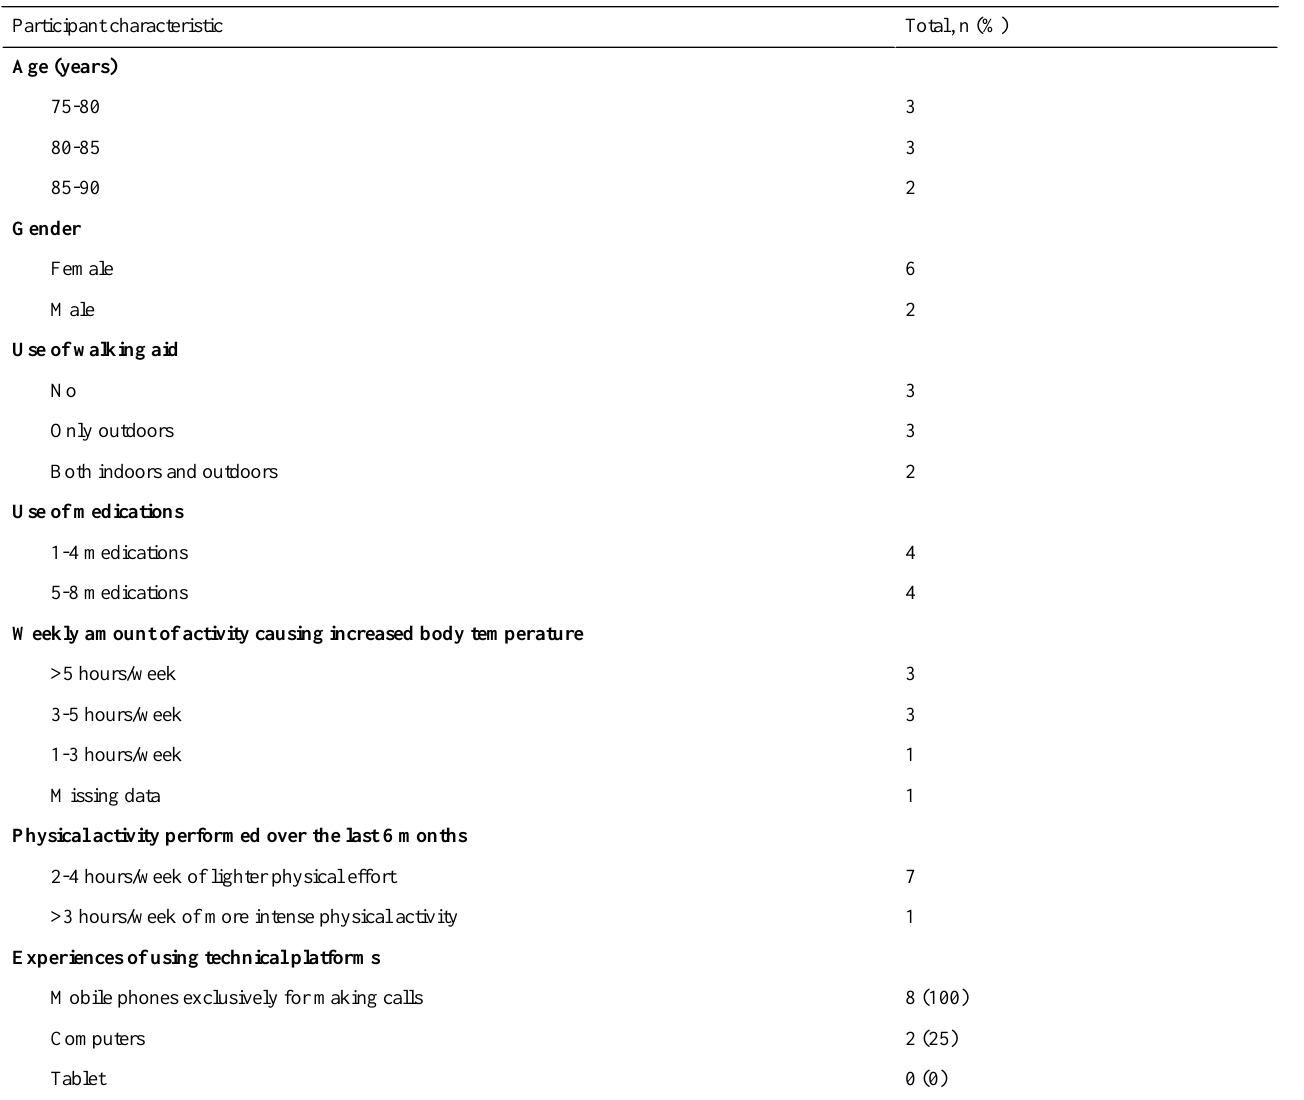
Table 1. Descriptives of the